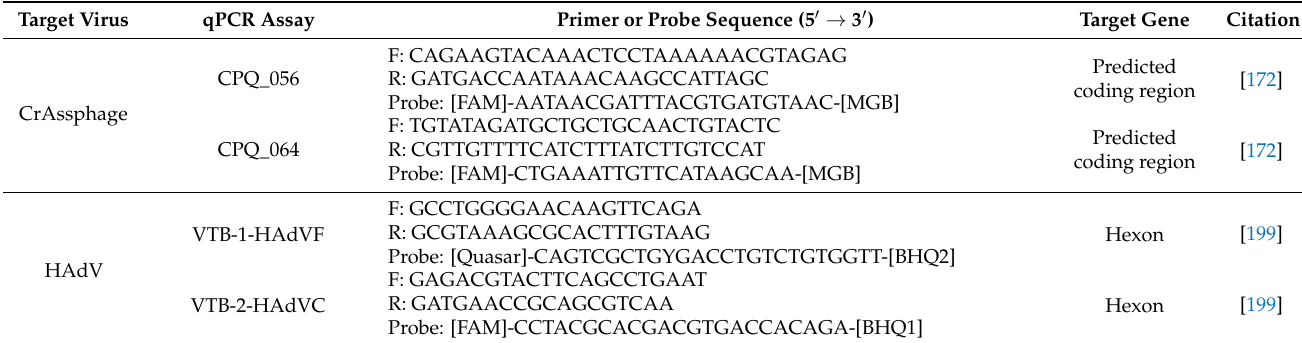
Table 3. Available primers for qPCR detection of crAssphage, HAdV and HPyV. Target Virus qPCR